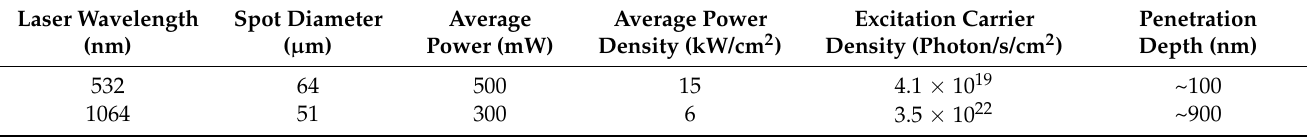
Figure 1. X-ray diffraction 004 ω /2 θ scans for samples ( a ) S14, ( c ) S15, ( d ) S29, and ( b ) S32 showing not much change in composition. The vertical dotted and dashed lines mark the peak positions of the as-grown GeSn and bulk Ge, respectively. Table 1. Summarized laser pumping